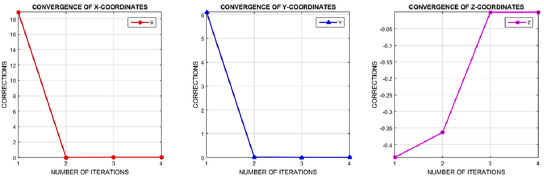
Figure 12. Convergence of pose corrections to zero values of the aerial image test.